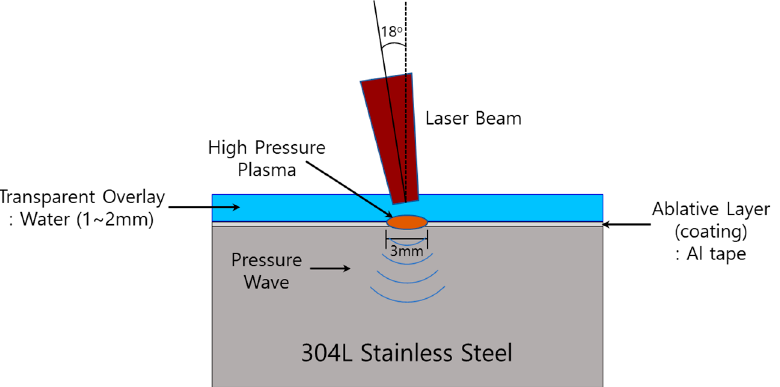
Figure 1. Schematic of laser peening process [18]. Table 4. Conditions of laser peening treatment [18].